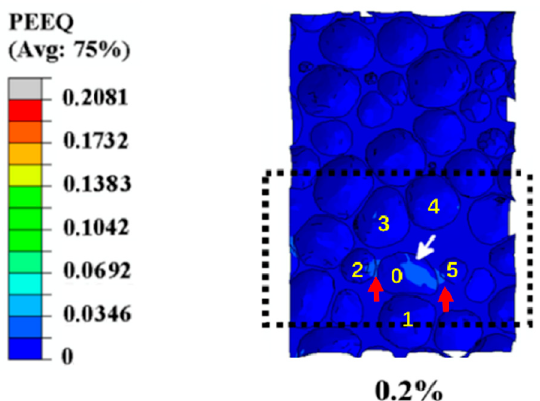
Figure 4. Illustration of the initial plastic strain in a large elliptical cells at strain level 0.2%.